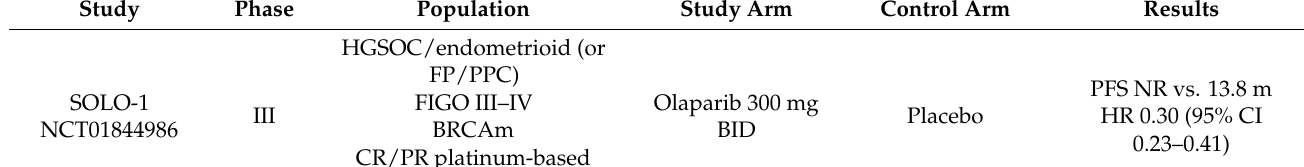
Table 3. Clinical trials of PARP inhibitors as maintenance in the front-line